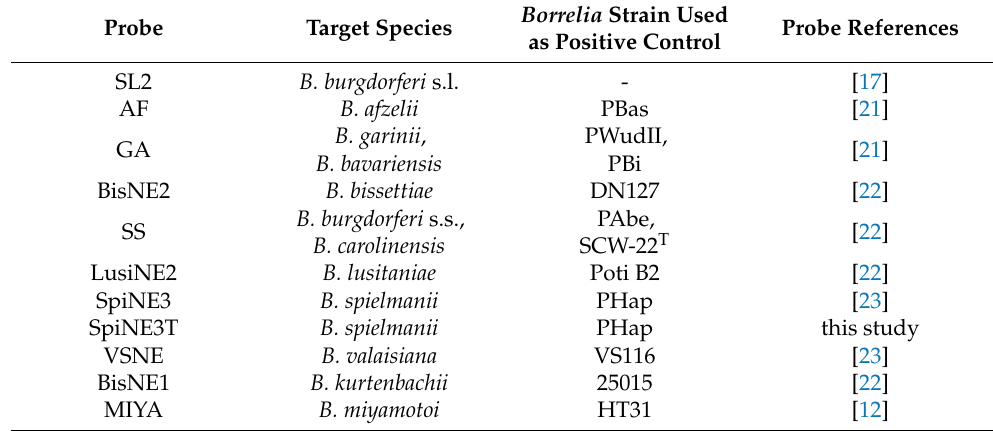
Table 2. Probes and positive controls used in the reverse line blot for Borrelia species discrimination.